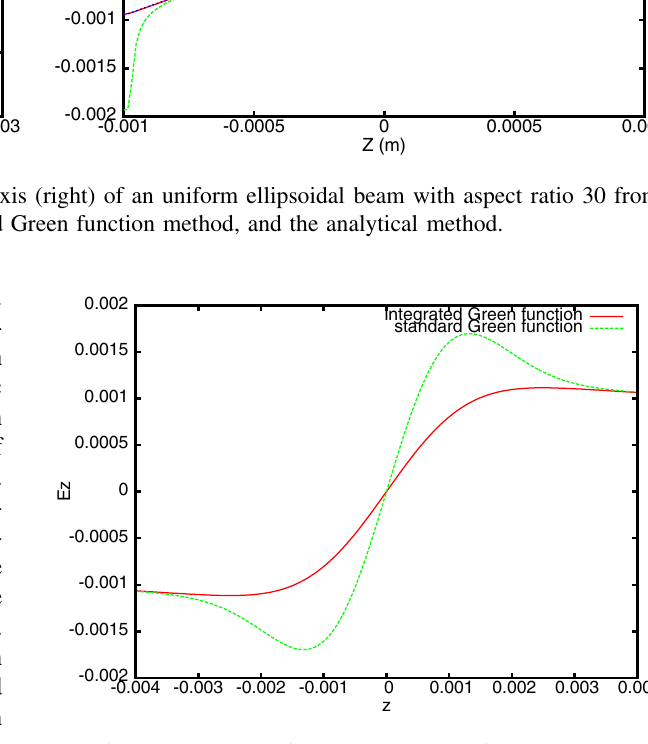
FIG. 6. (Color) Electric fields along z axis of a Gaussian beam with aspect ratio 30 from solutions of the integrated Green function method and the standard Green function